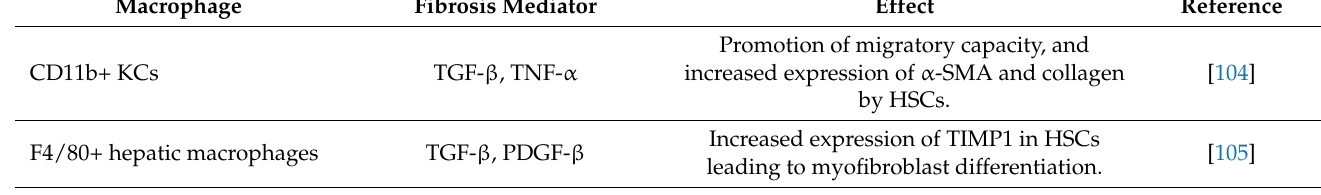
Table 3. Table summarizing how and which types of macrophages are involved in liver fibrosis. Transforming